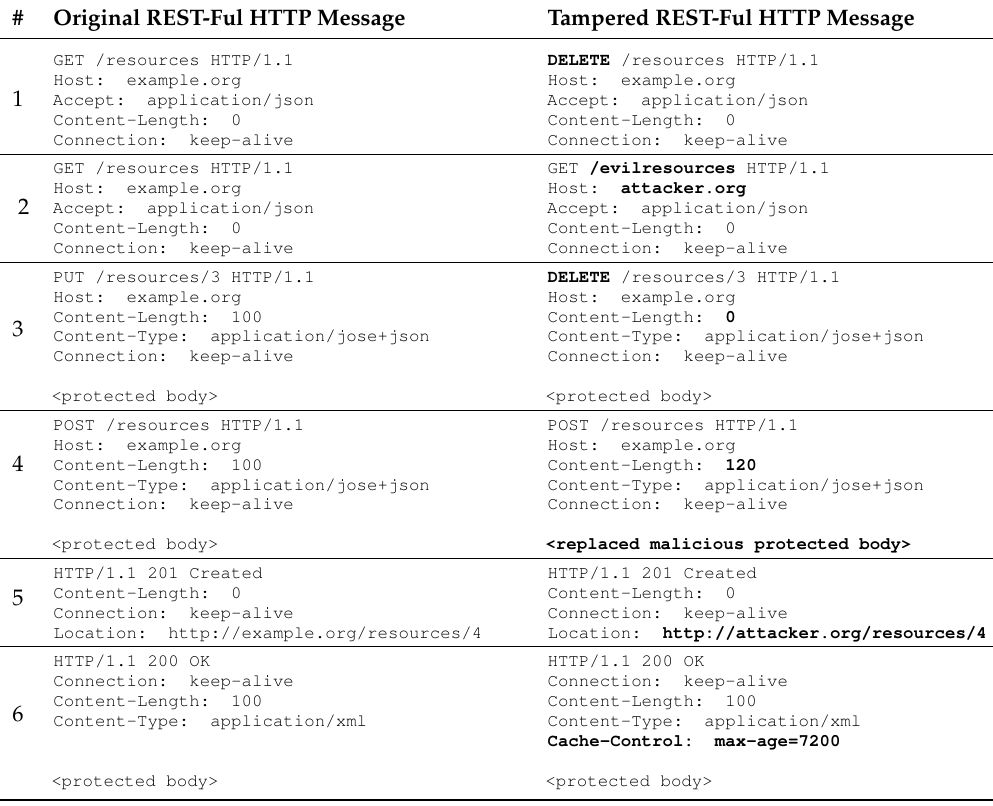
Table 1. Possible attack vectors on unauthenticated REST-ful HTTP